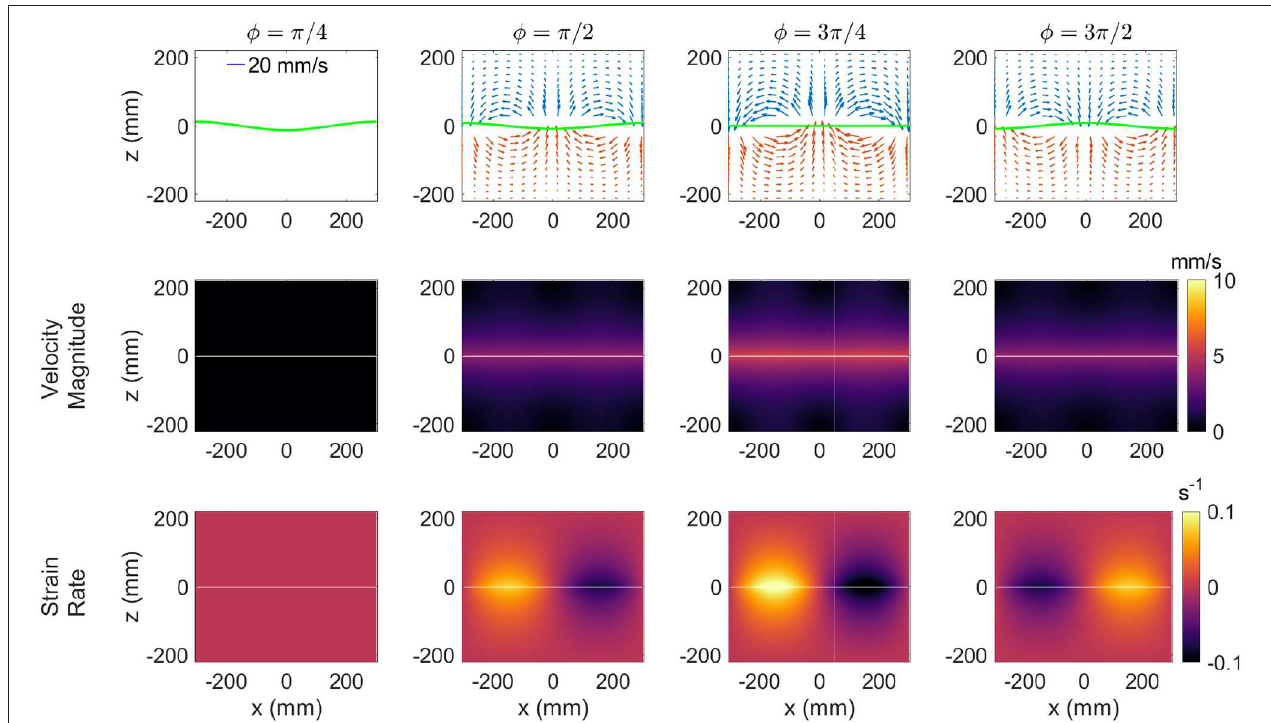
FIGURE 10 | The flow field in the standing internal wave cycle. The velocity field (Top) , contours of the velocity magnitude (Middle) , and contours of the strain rate (Bottom)